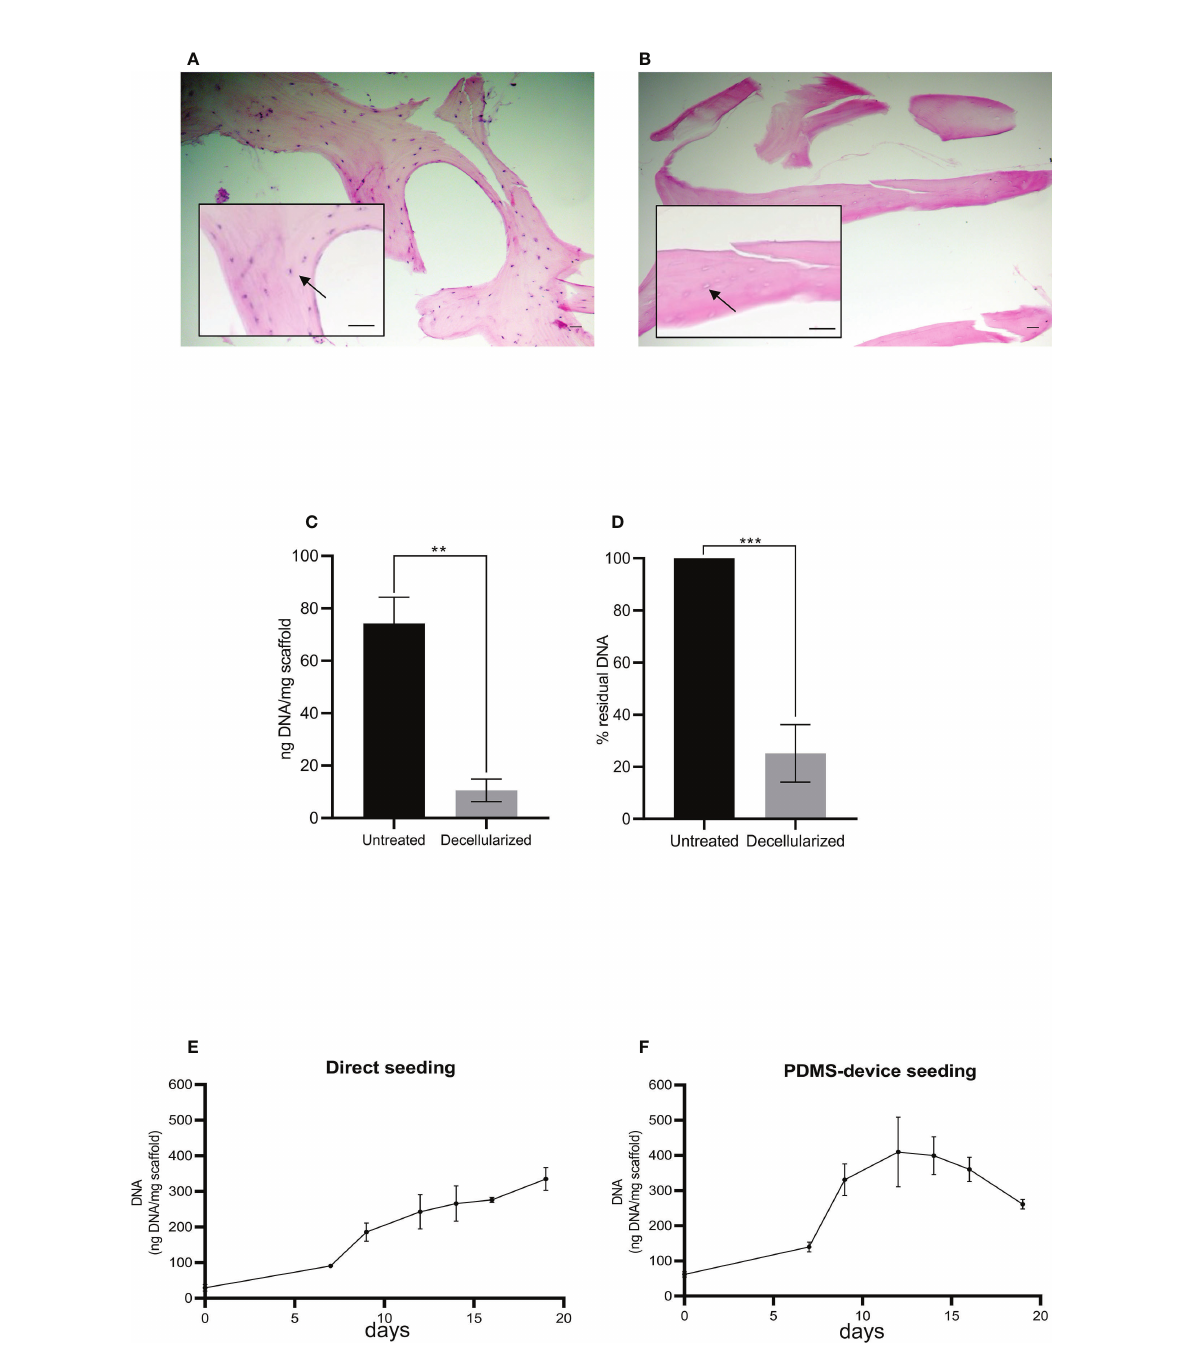
FIGURE 2 Histological sections of human femoral bone fragment before (A) and after (B) the decellularization process. Arrows indicate a bone cell (A) and the absence of a bone cell (B) . Hematoxylin/eosin staining. Scale bar: 100 m m. Histograms show total DNA content in the bone fragments after decellularization compared to the untreated ones (C, D) . Statistical analysis performed with unpaired t -test; n = 3; ** p < 0.005; *** p < 0.0005. (E, F) The total DNA content (ng), normalized to the weight in mg of the scaffold, as an index of cellular presence. The scaffolds were seeded with HS-5 cells directly (E) or directly plus the PDMS device (F) . Both seeding techniques allowed the attachment and the expansion of the cells into the scaffold: direct seeding allowed a constant and linear increase of cellular content, while double seeding permitted a quicker and higher recellularization of the